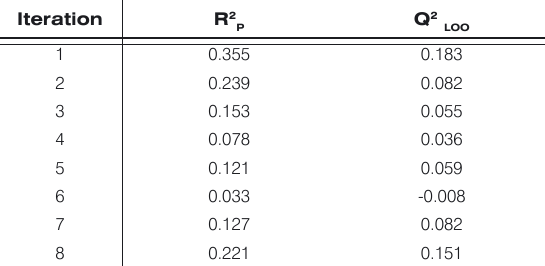
and Q 2 values after several Y-randomization LOO P